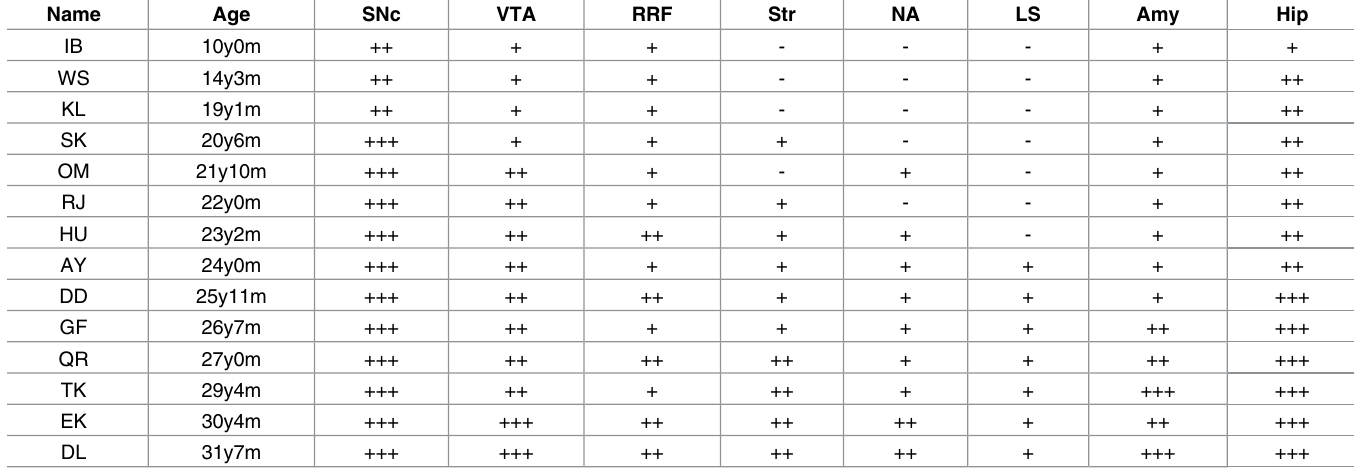
Table 2. Distribution patterns of α -syn-positive neurons in subcortical structures. -, none; +, sparse (1-10/ROI); ++, moderate(11-20/ROI); +++, dense(21-/ROI). Amy, amygdala;Hip, hippocampus; LS, lateral septum; m, months; NA, nucleusaccumbens;RRF, retrorubral field; SNc, substantianigra pars compacta; Str, striatum; VTA, ventral tegmental area; y,